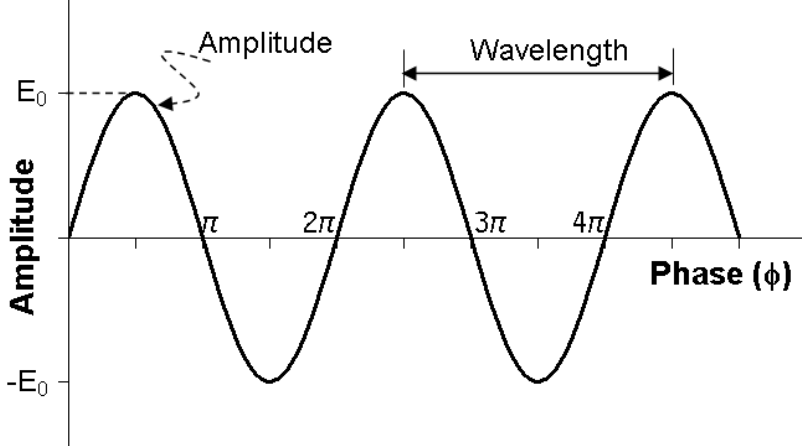
Figure 2. The relationship among amplitude, phase, and wavelength of a radar signal. The intensity of the radar signal is proportional to the squared